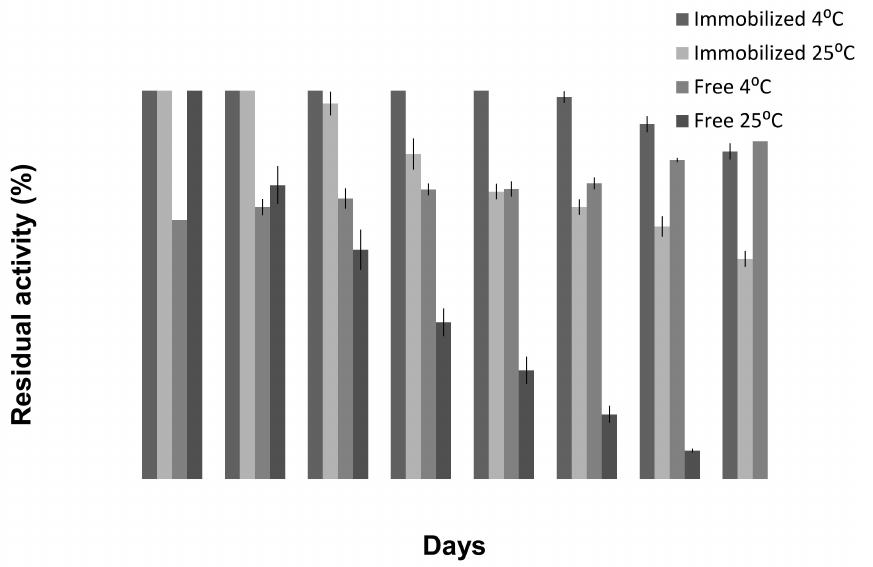
Figure 3. Activity retention rates (%) of free and immobilized B. stearothermophilus lipases at 4 ◦ C and 25 ◦ C. Data are expressed as the mean ± standard deviation of triplicate